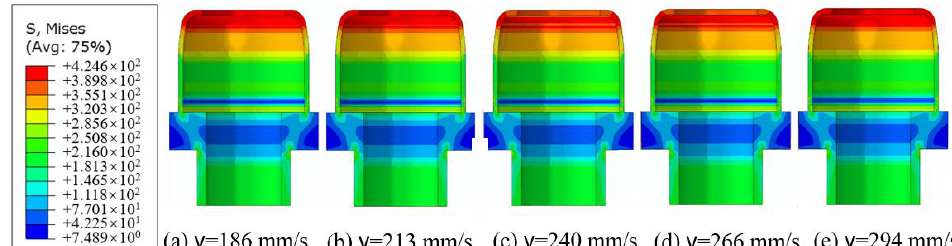
Figure 8. Effect of v on stamping.